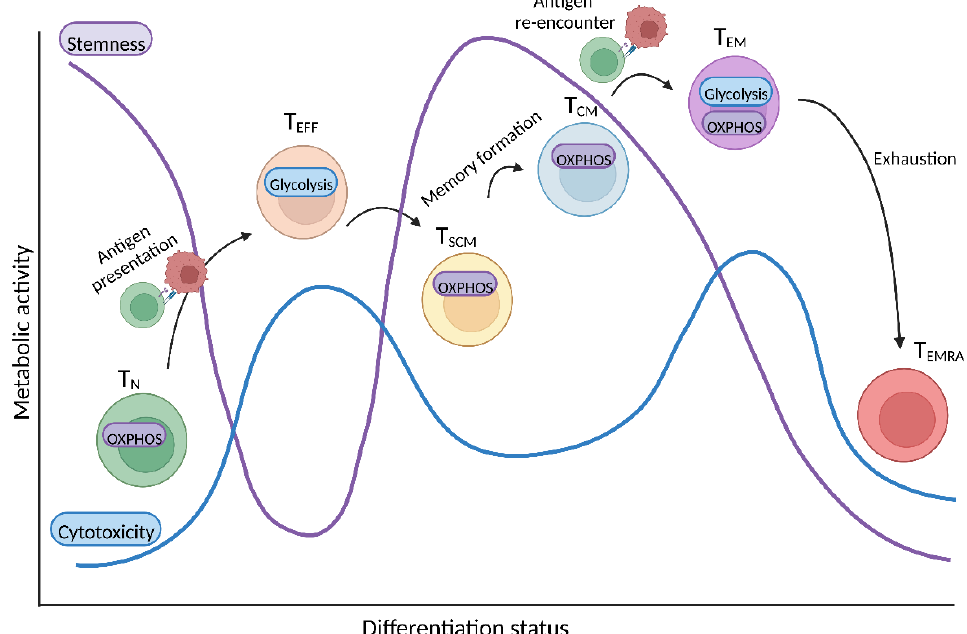
Figure 2. T cell differentiation is interconnected to metabolism. As naïve T cells (T N ) leave the thymus and undergo antigen presentation, they experience a metabolic switch from oxidative phosphorylation (OXPHOS) to glycolysis as they become effector T cells (T EFF ). After antigen clearance, a small subset of T cells become stem central (T SCM ) and central memory (T CM ) T cells, which mostly rely on OXPHOS. In case of TCR re-engagement, effector memory T cells (T EM ) rapidly shift to a high glycolytic activity that supports their strong effector function. Lastly, terminally differentiated T cells (T EMRA ) appeared rather senescent. T cell subsets that rely more on OXPHOS (T N , T SCM , T CM ) are characterized by stemness, self-renewal and proliferation capacity. On the contrary, glycolysis- fueled cells (T EM , T EFF ) display high cytotoxic function that ultimately leads them to senescence (T EMRA ).